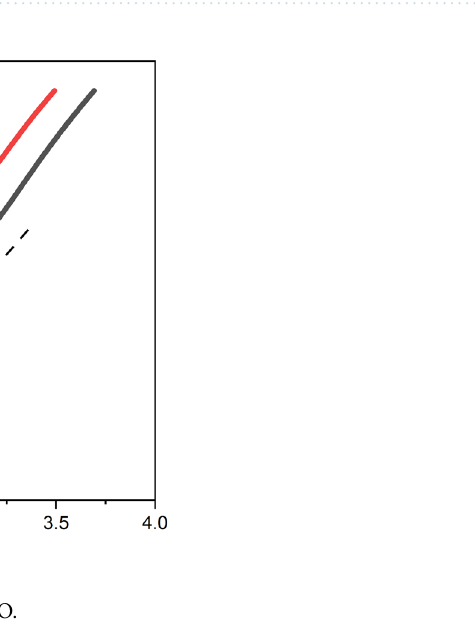
Table 2. Maximum absorption of different weight percentages of GO nanocomposites in different step times of exposure.